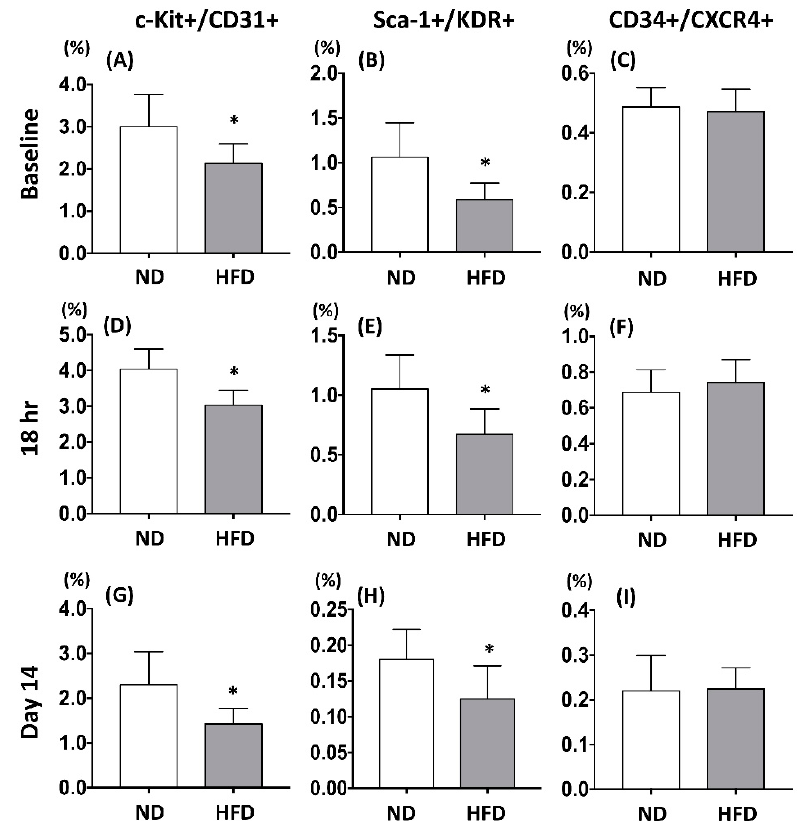
Figure 2. Maternal fructose exposure reduced the number of circulating endothelial progenitor cells. ( A – C ) The number of c-Kit+/CD31+, Sca-1+/KDR+, and CXCR4+/CD34+ in the peripheral bloods of the offspring prior to induction of critical limb ischemia (CLI). ( D – F ) The number of c-Kit/CD31, Sca-1/KDR, and CXCR4/CD34 in the peripheral bloods of the offspring 18 h post induction of CLI. ( G – I ) The number of c-Kit/CD31, Sca-1/KDR, and CXCR4/CD34 in the peripheral bloods of the offspring 14 days post induction of CLI. In normal condition, compared with the NC group, the number of circulating c-Kit+/CD31+ and Sca-1+/KDR+ EPCs were lower in the offspring with MFE. However, the number of CXCR4+/CD34+ cells was not affected by maternal fructose exposure. Eighteen hours and 14 days after induction of CLI. The circulating levels of c-Kit+/CD31+ and Sca-1+/KDR+ cells in MFE group was lower than that in the NC group, while levels of CXCR4+/CD34+ cells showed no difference between the two groups. NC, normal control; MFE, maternal fructose exposure; CLI, critical limb ischemia. Error bars represent the standard deviation (SD). * Indicates statistical significance between NC and MFE group. n = 8 for each group.